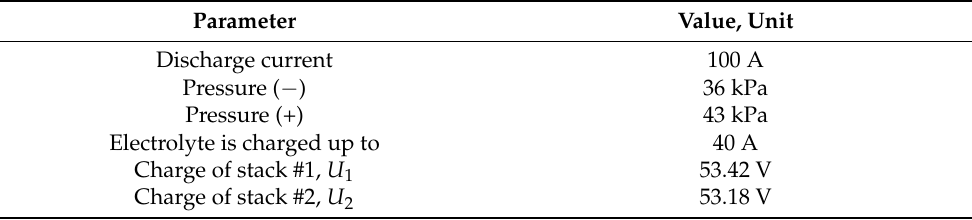
Table 4. Initial data for